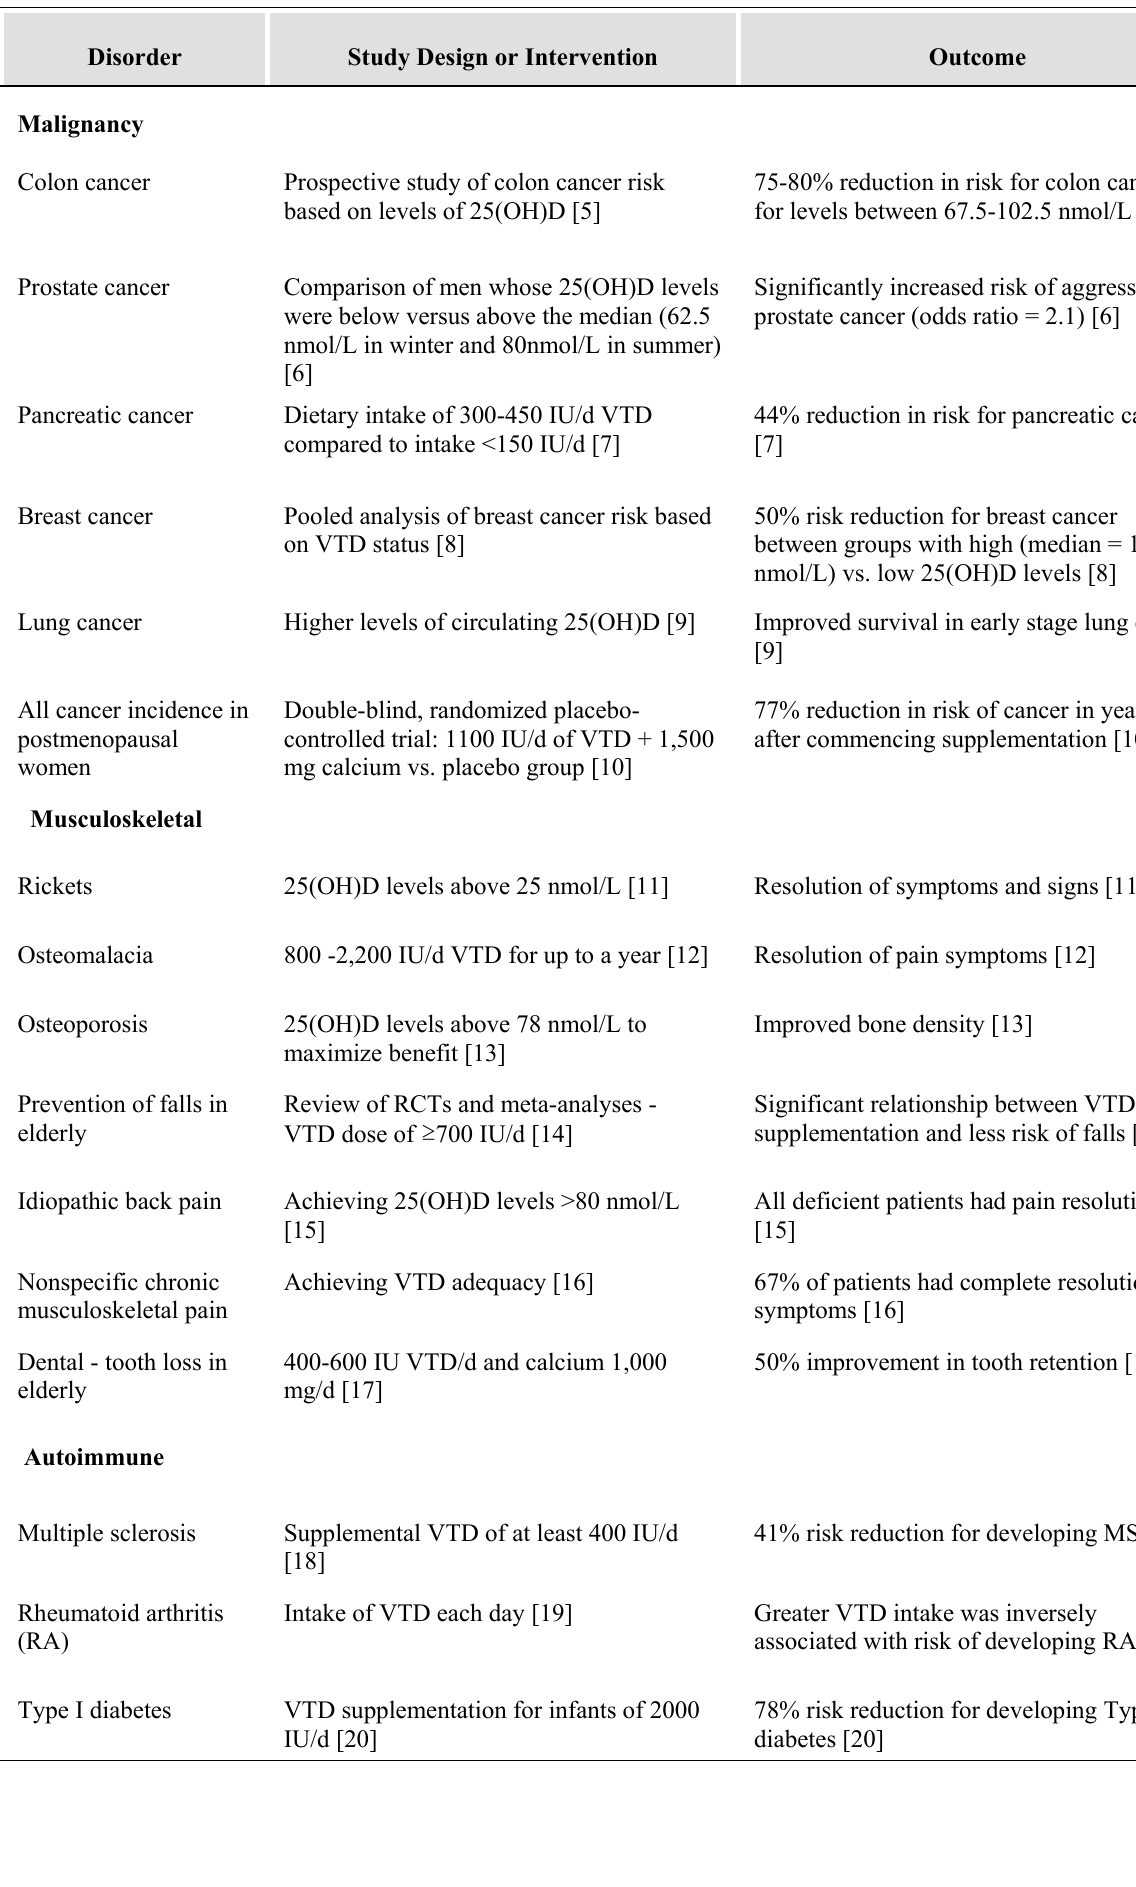
Table 1. Examples of VTD Status and Clinical